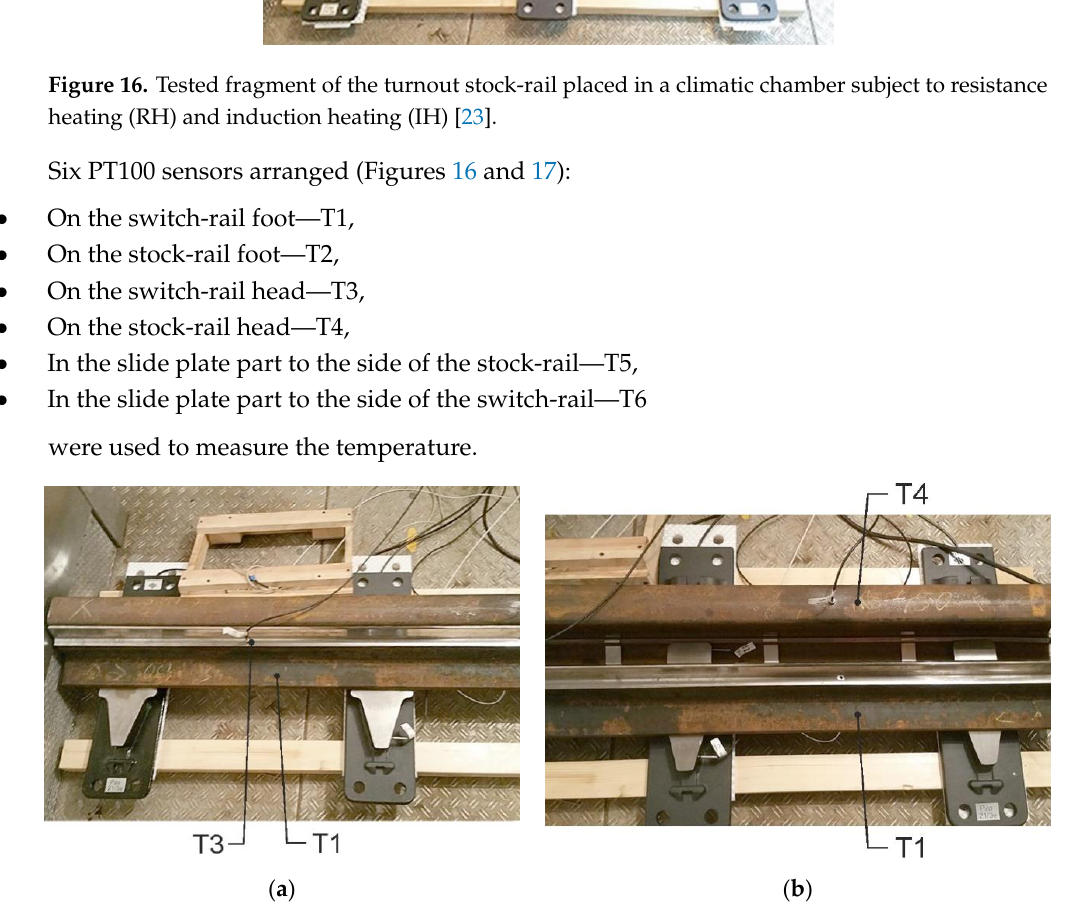
Figure 17. Arrangement of temperature measurement sensors around the turnout for: ( a ) the switch-rail touching the stock-rail; ( b ) the switch-rail away from the stock-rail [23].